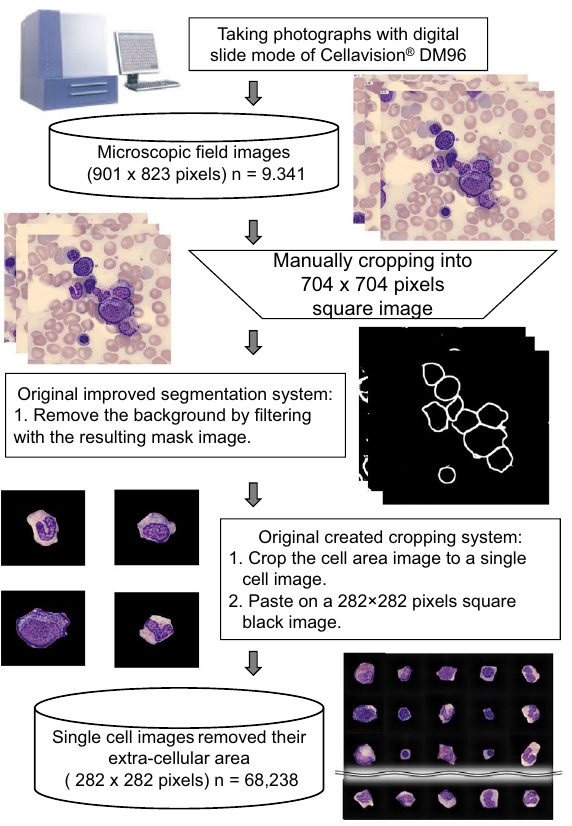
Figure 4. Flow of preprocessing and sample images. Microscopic field images (901 × 823) were taken with an automatic microscope (CELLAVISION DM 96). They were then cropped to 704 × 704 square images for input to the cell segmentation neural network. Square images were then input into the system to obtain 282 × 282 individual single-cell images. The inverted trapezoidal frame shows manual processing. The rectangular frame shows automatic processing or processing by hand-made programs written in Python and Cellavision